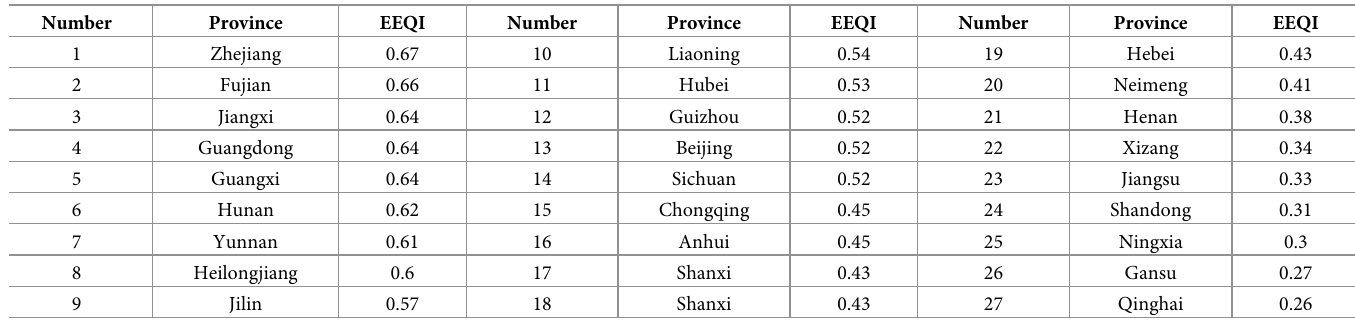
Table 5. Ecological environmental quality index of 27 provinces.